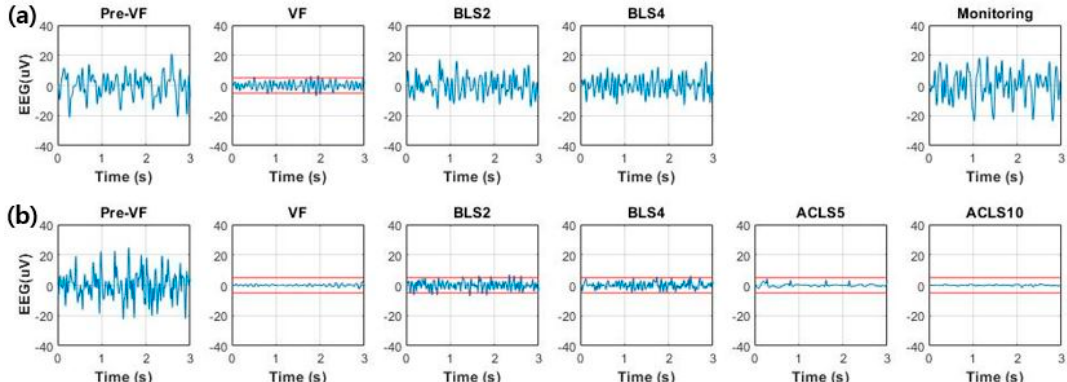
Figure 3. Comparison of EEG over time between return of spontaneous circulation (ROSC) and non-ROSC cases: ( a ) EEG waveforms obtained from animals with successful defibrillation after fourth BLS session and sustained ROSC confirmed after follow-up monitoring for 20 min (Test 6); ( b ) EEG waveforms obtained from animals in which ROSC was not achieved until the end of experiment (Test 5). Dashed lines denote the level of ± 5 µ V, the limits of the isoelectric state.